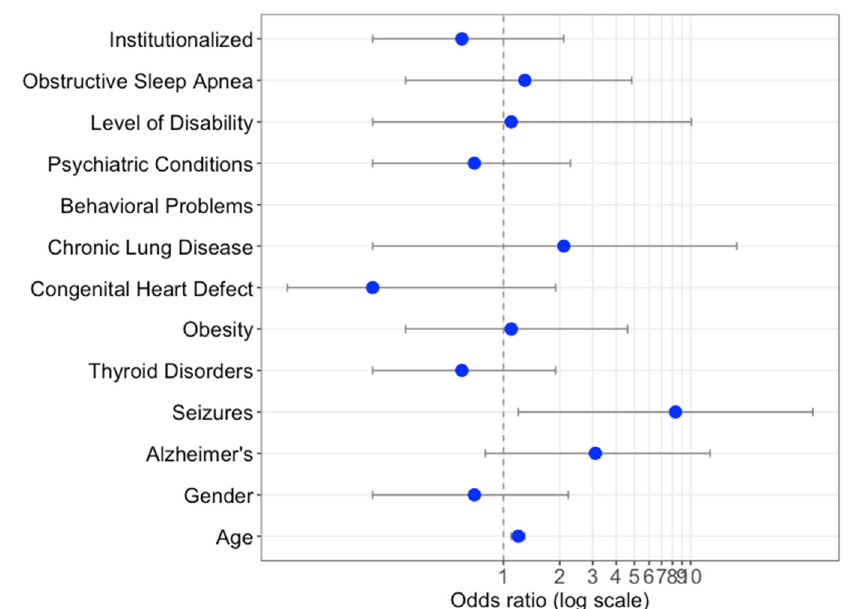
Figure 2. Risk factors and their association with mortality in patients with DS and COVID-19. Age and gender were adjusted by survey, and all of the risk factors were adjusted by age, gender, and source of data (family or clinician survey).